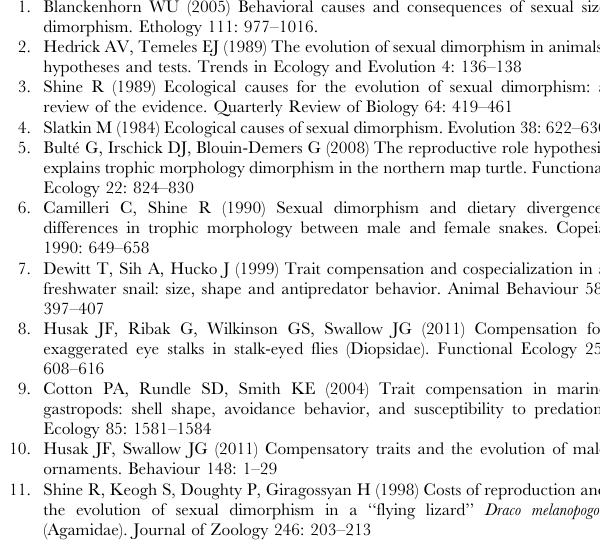
Table S1 Summary of tests on allometric scaling relationships of morphological traits with body length and sex differences in allometric elevation. Estimated allometric slopes for each sex are presented with 95% confidence intervals below. Test statistics and p-values are derived from likelihood ratio tests (LRT) performed in standardized major axis regression as described in [44], and all traits except relative metasoma thickness were log-transformed for analysis. Mass is expected to increase as a function of the third power of linear measurements, so isometry is indicated by a slope of three on the (log-transformed) mass variables. Relative metasoma thickness was calculated as metasoma mass divided by metasoma length, with mass transformed according to its empirical scaling relationship with length (2.38th -root transformed; see below). Because metasoma thickness is already relative to length, isometry here is indicated by a slope of